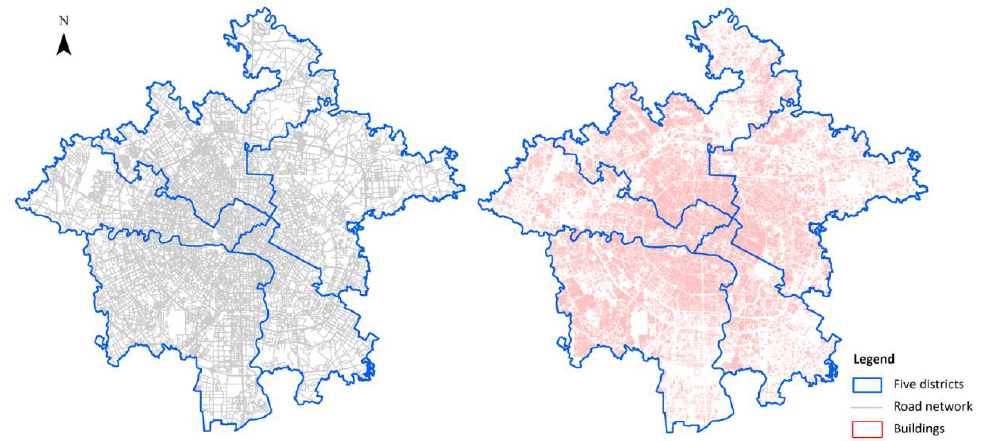
Figure 2. Road network (left) and building vector data (right).